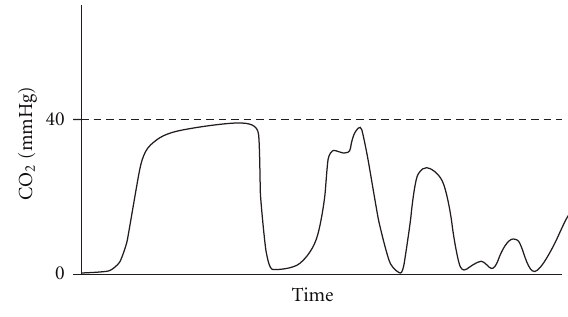
Figure 4: Obstruction of the airways.